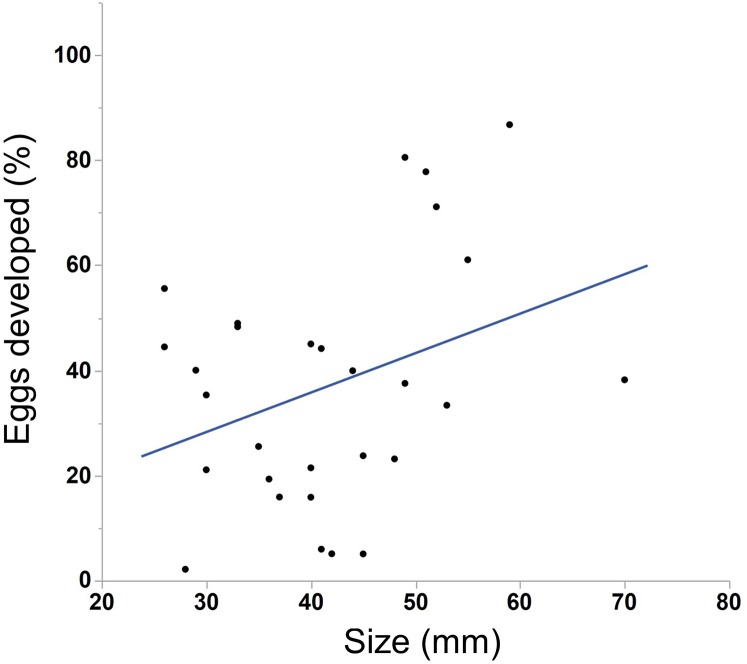
Correlation between body size and egg viability in M. leidyi.Body size positively correlated with the percentage of eggs that developed after 24 h, although the result was not significant (N = 29, r2 = 0.12, p = 0.07).